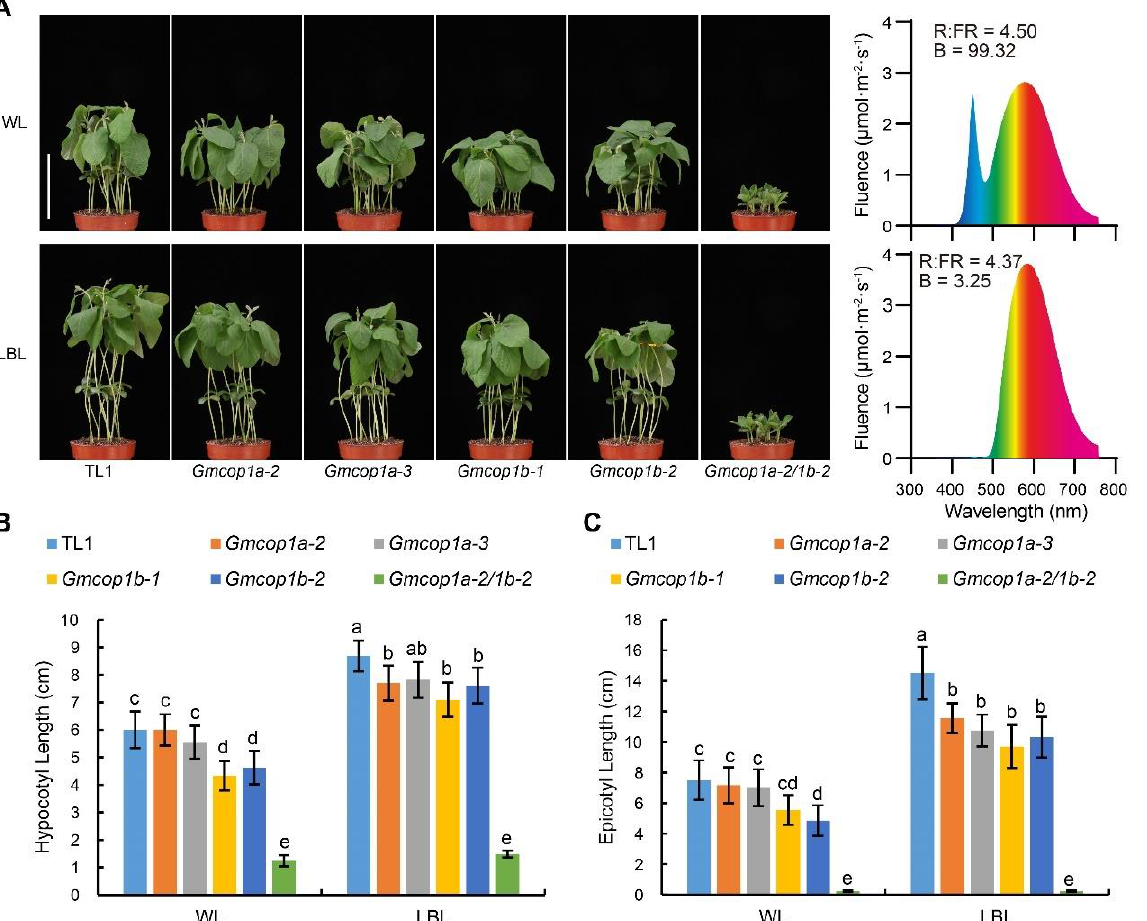
Figure 5. Comparisons of LBL-induced stem elongation among different GmCOP1s mutant lines. ( A ) Left panel: Representative images of indicated lines subjected to white light (WL) or LBL treatment. Right panel: the spectrum of WL and LBL. The intensity of photosynthetically active radiation (PAR) (400–700 nm) of WL or LB is 500 µ mol · m − 2 · S − 1 . Seedlings germinated using white light under long-day (16 h light/8 h dark) conditions for 3 days, then grown under long-day conditions with the indicated light for 7 days. Scale bar = 10 cm. ( B , C ) Statistical analysis of hypocotyl length ( B ) and epicotyl length ( C ) of the seedlings in ( A ). The values represent the means ± SD ( n ≥ 8). The lowercase letters indicate significant differences as determined by two-way ANOVA with Tukey’s post hoc test ( p < 0.01).